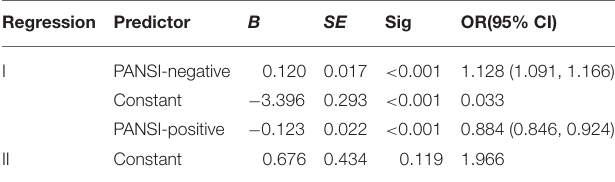
TABLE 3 | PANSI-negative and PANSI-positive scores for psychiatric and medical patients.